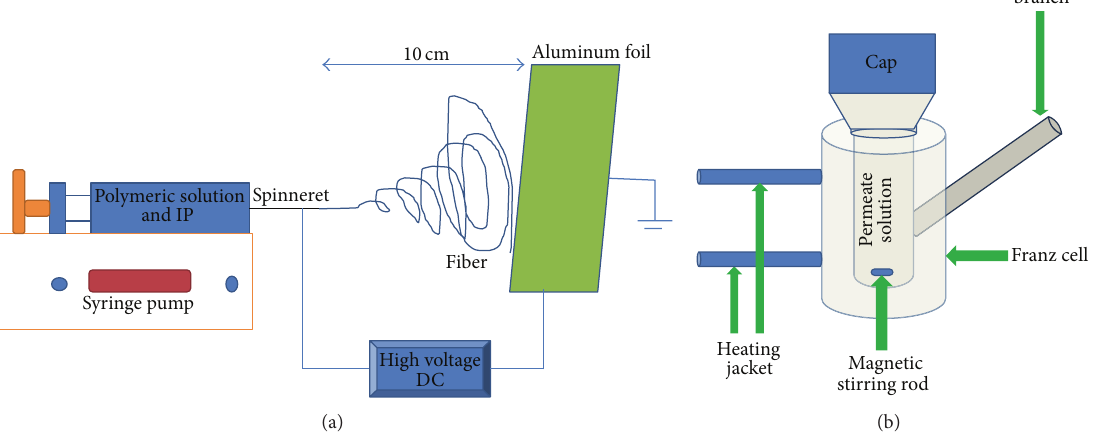
Figure 1: Schematic of (a) the electrospinning setup for the fabrication of PCL and pNIPAM-co-MAA MFs containing ibuprofen; (b) the Franz diffusion cell used for the drug diffusion studies.